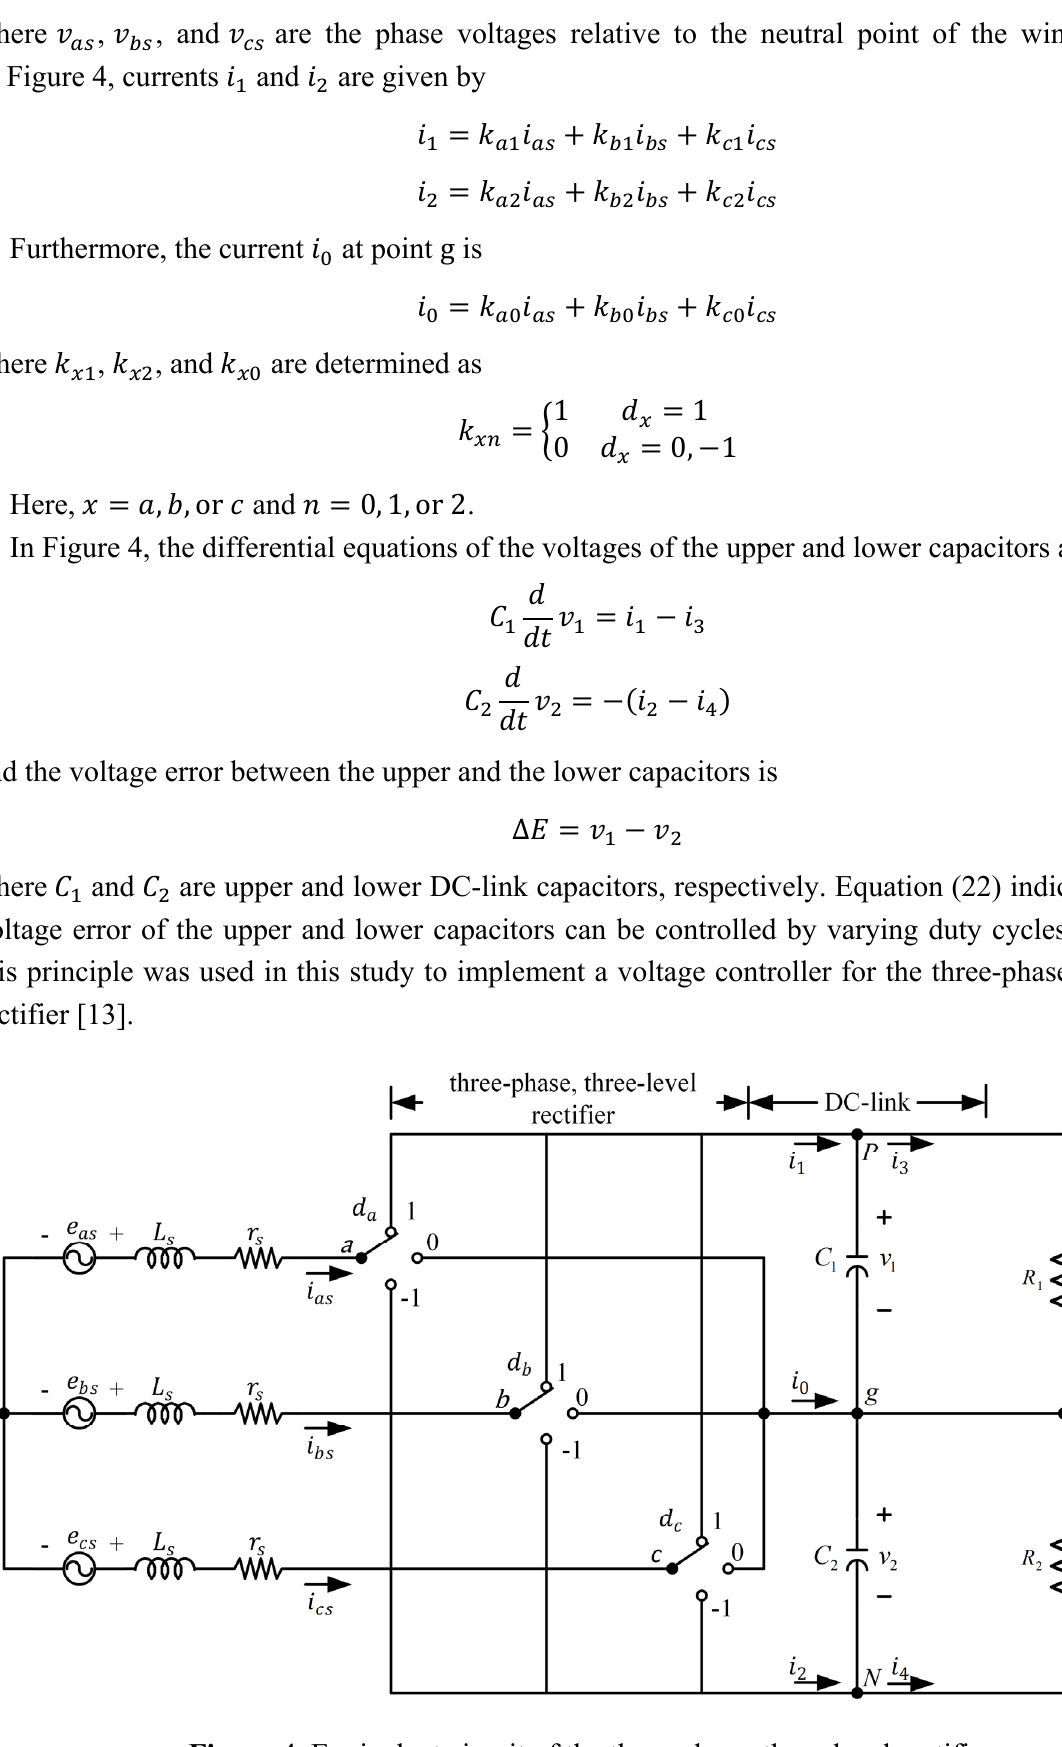
Figure 4. Equivalent circuit of the three-phase, three-level